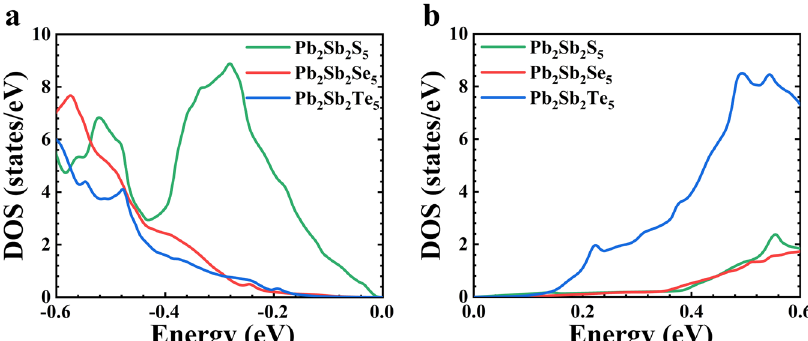
Fig. 6 Density of states around band edges. Total DOS of a valence and b conduction band edges for Pb 2 Sb 2 S 5 , Pb 2 Sb 2 Se 5 , and Pb 2 Sb 2 Te 5 , with the zero-energy points representing respective VBMs and